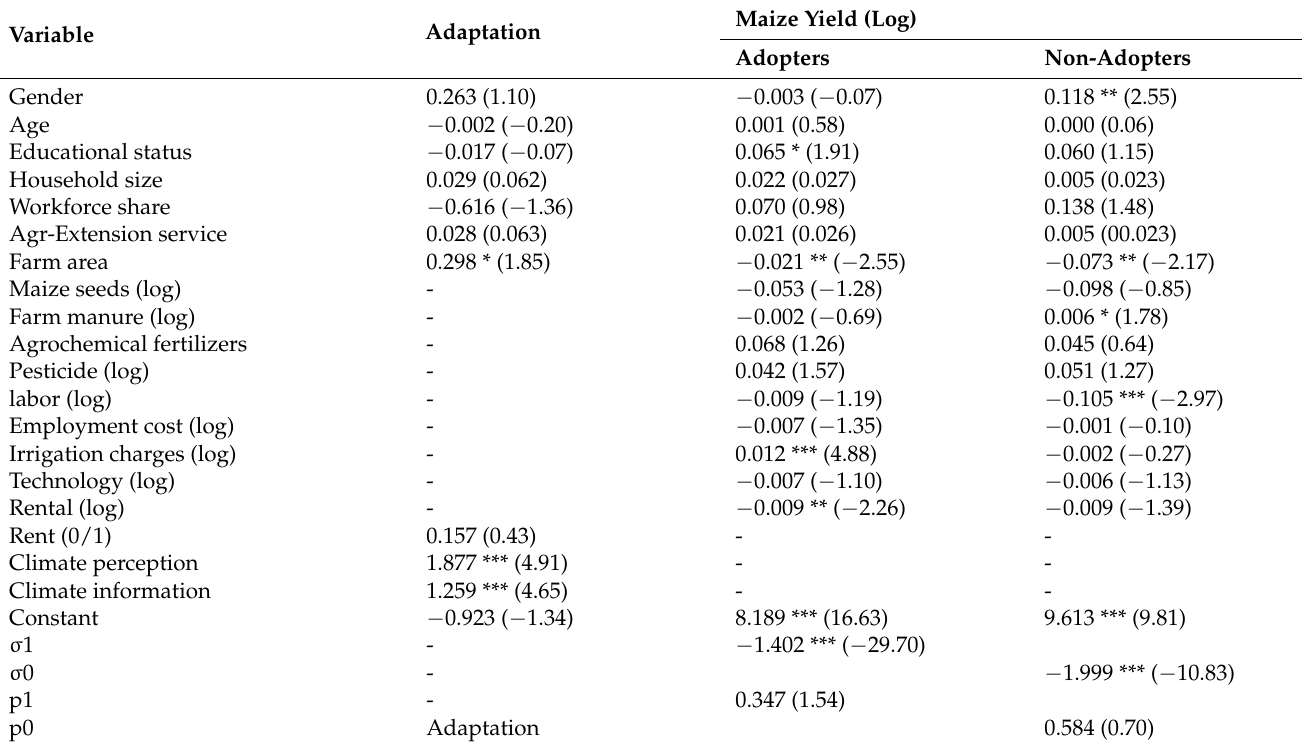
Table 3. Regression results from endogenous switching of CC adaptation and influences maize productivity.